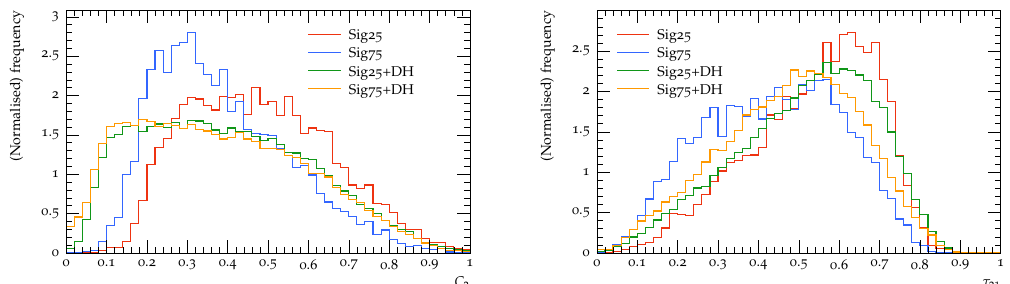
Figure 13: Comparisons of C (left) and τ (right) for different signals correspond- 2 21 ing to R values of 0.25 and 0.75, clustering only the visible hadrons and clustering inv also with final dark